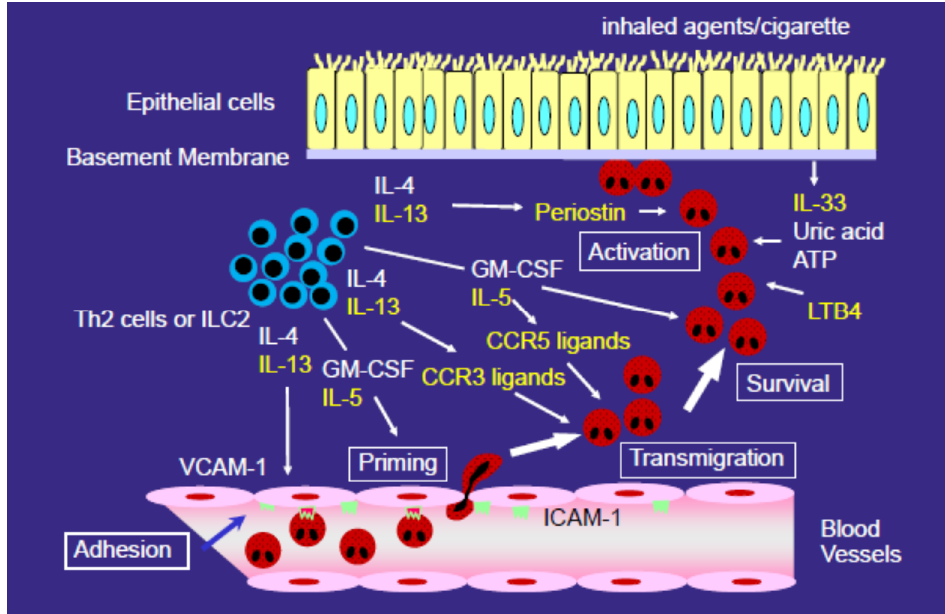
Figure 2. Possible mechanisms of eosinophil accumulation in the airway in eosinophilic pneumonia. Eosinophils must adhere to and migrate across vascular endothelial cells to accumulate in airways. vascular cell adhesion molecule (VCAM)-1 is an adhesion molecule expressed on endothelial cells, and it is specifically important for eosinophil adhesion. Cc chemokine receptor (CCR)3 ligands, including eotaxin-2 (CCL26) and MCP-4 (CCL13), and CCR5 ligands, including MIP-1β (CCL4), all play important roles in eosinophil migration. IL-4 and IL-13 are important for eosinophil accumulation, because they increase the expression of VCAM-1 and the expression of CCR3 ligands. IL-5 contributes to eosinophil accumulation by priming eosinophils and enhancing their survival. LTB 4 , damage-associated molecular pattern molecules (DAMPs), including IL-33, and extracellular matrix proteins, including periostin, have been found or suggested to play roles in the accumulation or activation of eosinophils. Periostin directly activates eosinophils and induces migration, and thereby plays a role in the accumulation of eosinophils in the airway. Yellow font indicates what we consider to be important mediators/molecules in the development of EP.